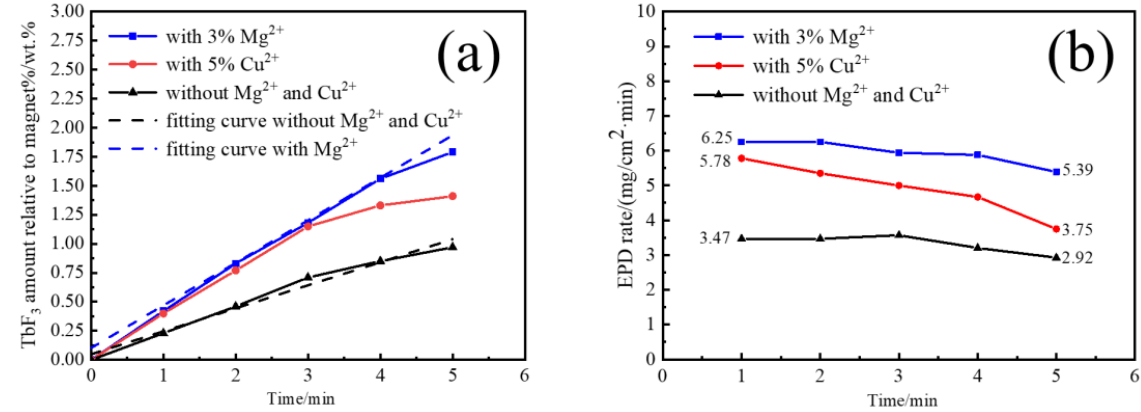
Figure 2. EPD TbF 3 amount ( a ) and EPD rate ( b ) of nano-TbF 3 at different EPD times.